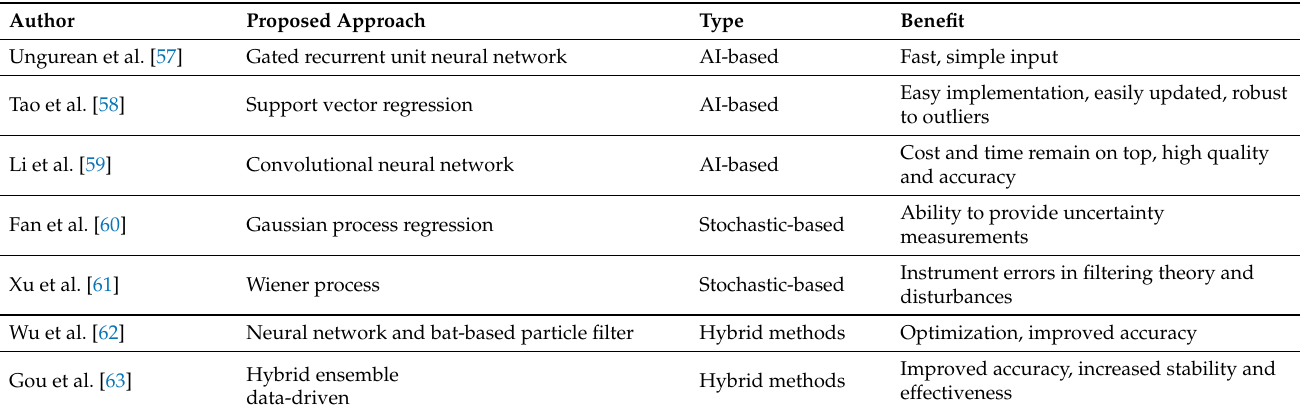
Table 1. Comparison of different RUL prediction